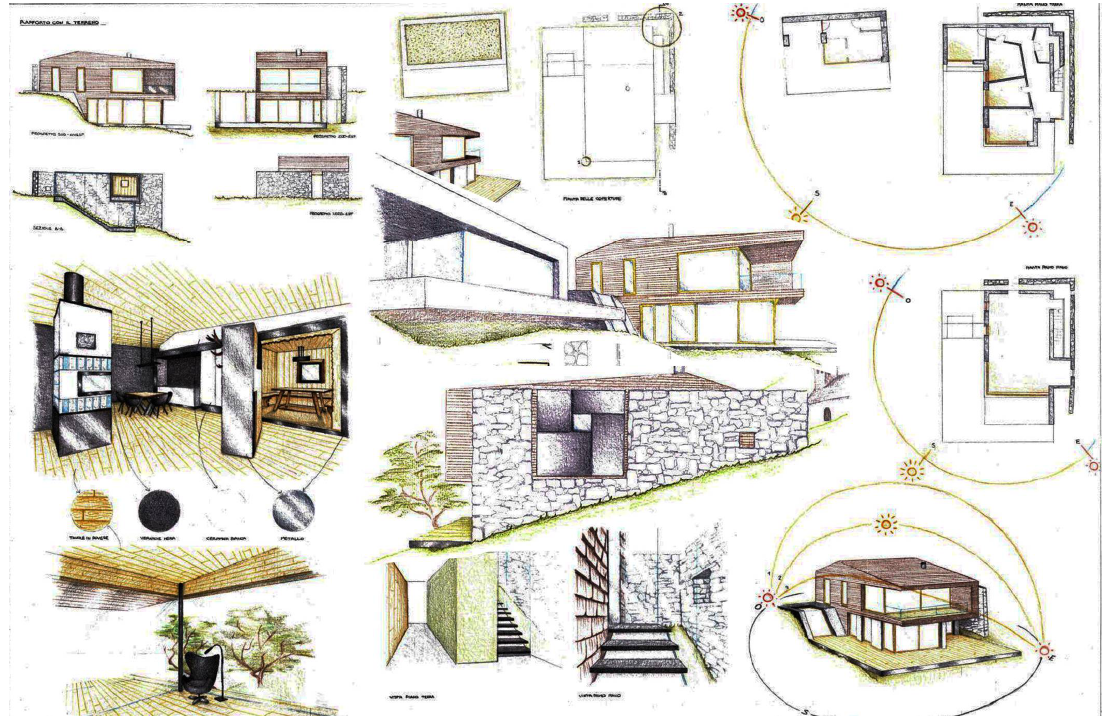
Figure 4. Graphical analysis. Study of House in Vipiteno, architect Bergmeisterwolf (student Francesca Marion